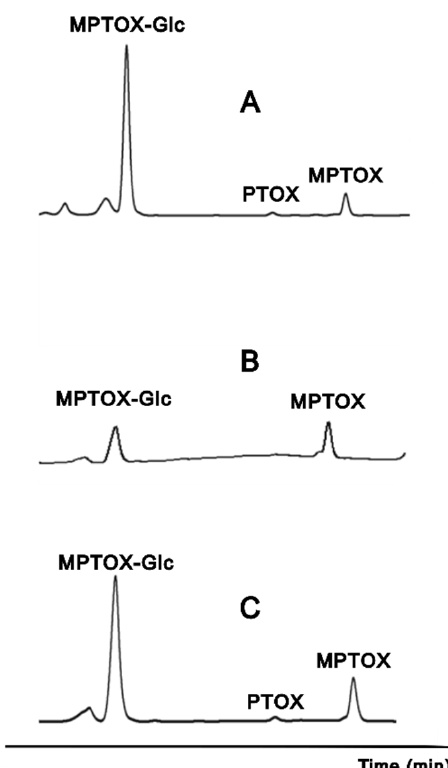
Figure 4. HPLC chromatograms of the ATLs portion, 18 to 24 min at 254 nm, COR-treated extract from ( A ): L. flavum , ( B ): L. mucronatum ( C ): L. dolomiticum . MPTOX–Glc (R t 18.8 min), PTOX (R t 22.2